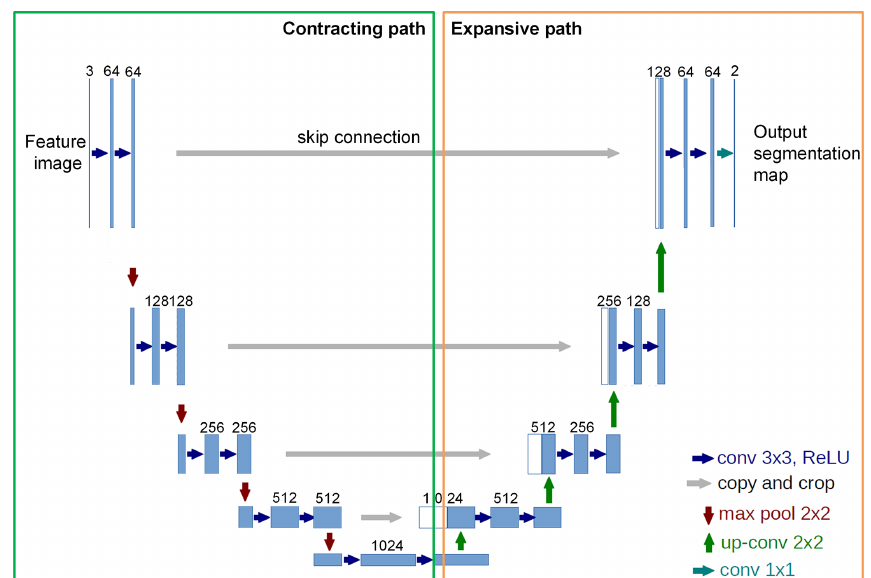
Figure 5. Structure of the U-Net